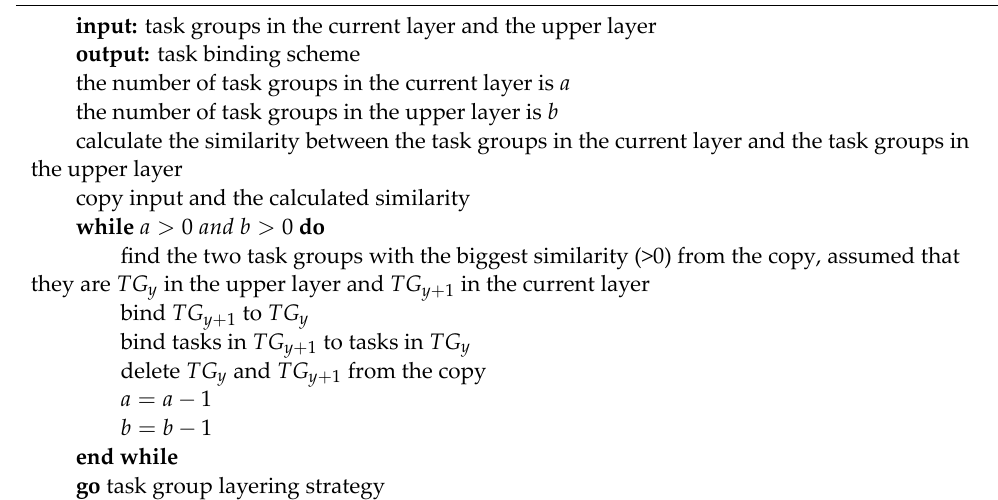
Algorithm 2. Task binding method pseudo